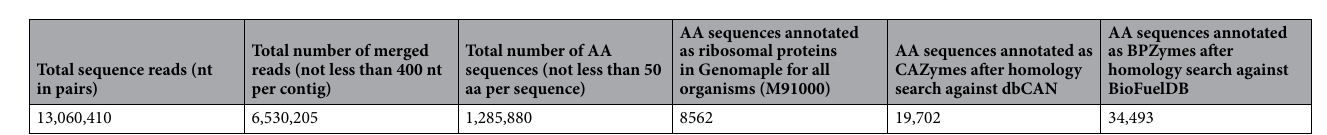
Total sequence reads (nt in pairs)